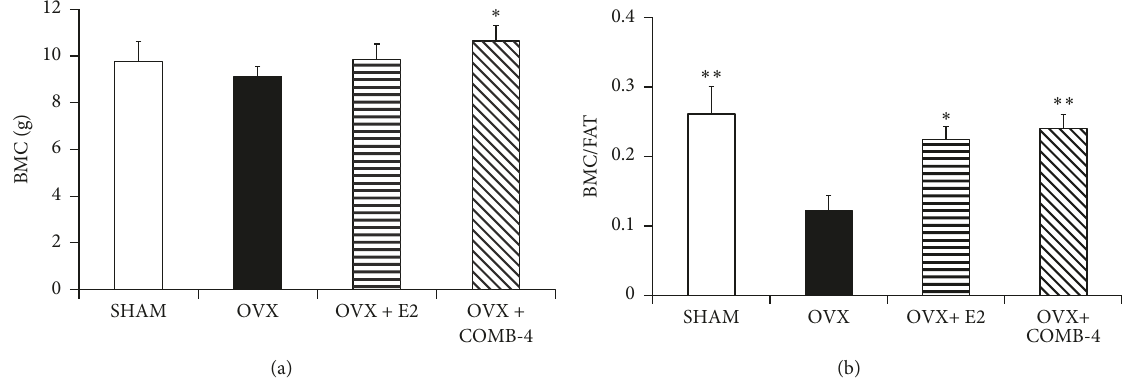
Figure 3: Effect of 100 days treatment with E2 or COMB-4 on Bone Mineral Content following OVX. Panel (a): bone mineral content (BMC; g + SEM) determined by DXA scan in SHAM, OVX, E2 (OVX+E2), and COMB-4 (OVX+COMB-4). ∗∗ p < 0.01 respect to OVX; # p < 0.05 respect to SHAM. Panel (b): BMD normalized by fat content in SHAM. OVX, E2 (OVX+E2), and COMB-4 (OVX+COMB-4). ∗ p < 0.05; ∗∗ p < 0.01 with respect to OVX. n = 8 per group.